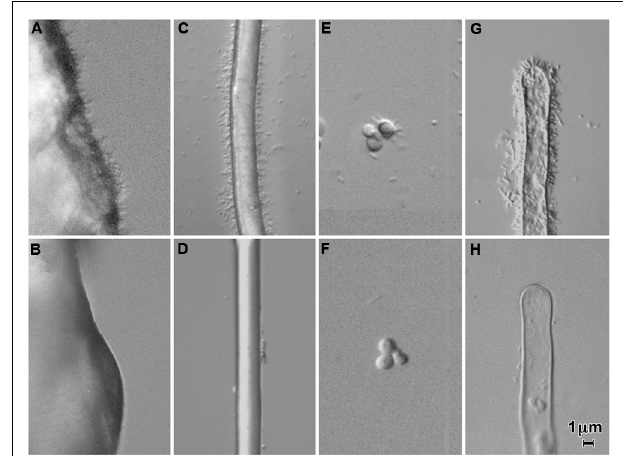
FIGURE 1 |Attachment of Agrobacterium tumefaciens strain C58 (A,C,E,G) and a UPP-deletion mutant of C58 (B,D,F,H) to quartz sand (A,B), polyester thread (C,D), yeast ( Saccharomyces cerevisiae ; C,F), and tomato root hairs (G,H) in a 1/10 dilution of MS medium containing a 1/20 dilution ofAB minimal medium. Note the copious attachment of wild-type cells and the large decrease in attachment in a UPP deletion mutant. Approximately 10 6 bacteria per ml were incubated with the substrate for 24